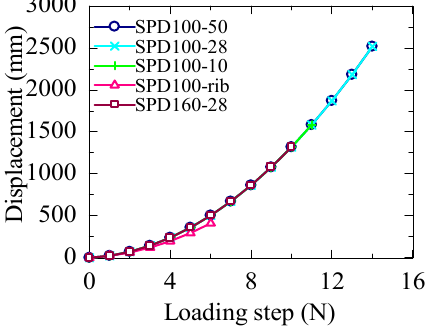
Figure 7. Cumulative displacement.